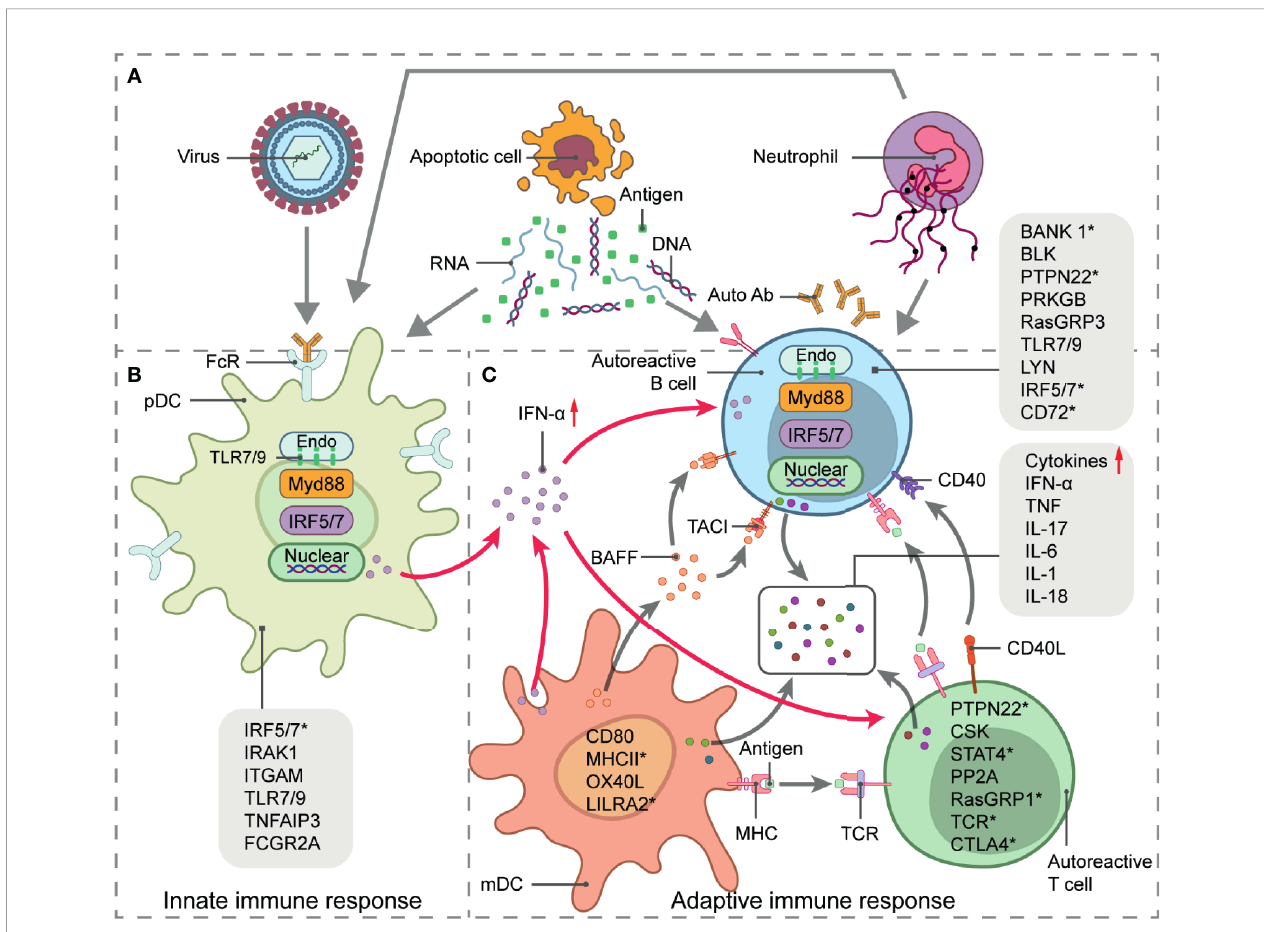
FIGURE 2 | Systemic lupus erythematosus (SLE) genetics and pathogenesis. Schematic picture of SLE immunopathogenesis and alternative splicing involved in signaling pathways-related genes. (A) Source of autoantigens initiating innate and adaptive responses in SLE include viruses, apoptotic material, and neutrophil extracellular trap (NET) formation. (B) pDC activation, antigen presentation, and IFN- a secretion. (C) IFN- a signaling pathway stimulates T- and B-cell activation, which leads to autoantibody and proin fl ammatory cytokine production and eventual local tissue injury. Straight arrows represent stimulation and curved arrows represent target process activation or production. SLE-related susceptibility genes are indicated in immune signaling steps. Genes with * undergo alternative